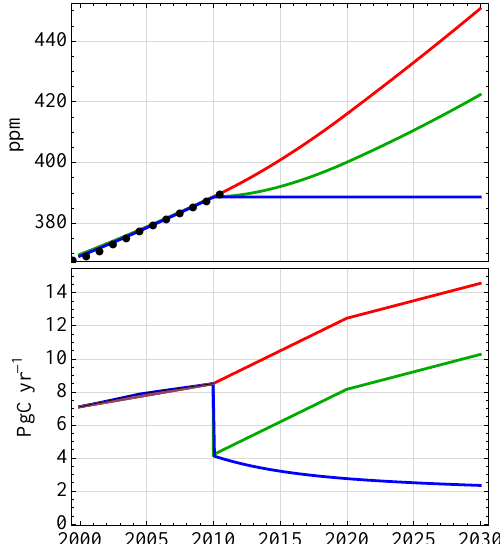
Fig. 1. Global carbon cycle model simulations with the Bern2.5CC model (Joos et al., 2001). Upper panel: atmospheric mixing ra- tio; lower panel: corresponding total anthropogenic emissions. Red lines: RCP 8.5 reference scenario (Riahi et al., 2007); green lines: effect of adding an additional sink of 4.3PgCyr − 1 in the year 2010; blue lines: a scenario with an assumed stabilisation at an atmo- spheric CO 2 level of 390ppm after the year 2010. The black dots show the atmospheric